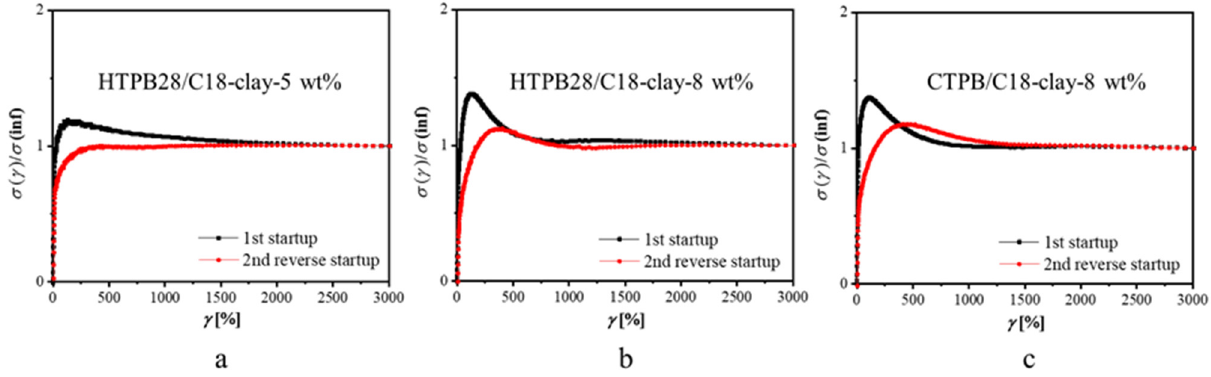
Figure 6. Transient stress response of samples with different clay concentrations ( a ) HTPB28/C18-Clay-5 wt%; ( b ) HTPB28/C18-Clay-8 wt% and matrix viscosity ( c ) CTPB/C18-Clay-8 wt% in the reverse flow measurements at 20 °C. A shear rate of 10 s − 1 was chosen.